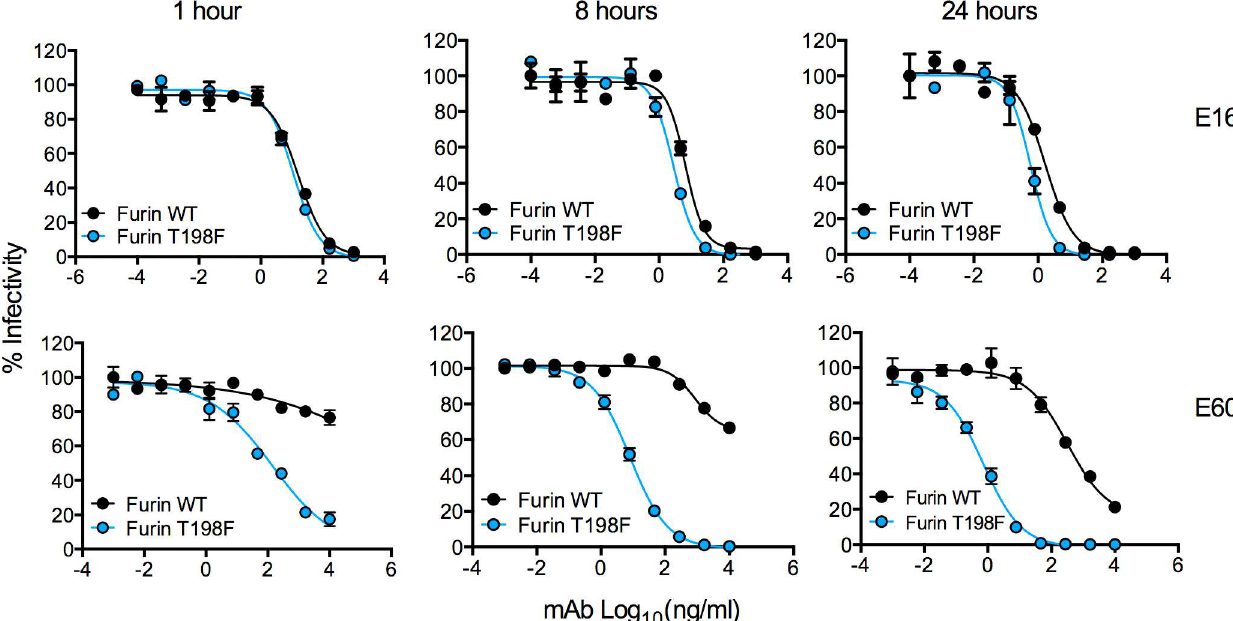
Fig 6. Kinetic aspects of neutralization of WNV E T198F RVPs. Furin WT and Furin T198F WNV RVPs were incubatedwith mAb E16 (top panel)or E60 (bottom panel)for 1 h at room temperature and were either immediately used to infect Raji-DC-SIGN-R cells or were further incubatedat 37˚C for additionallengthsof time as indicatedabovethe graphs prior to the addition of Raji-DC-SIGN-R cells. Percent infectivity versus mAb concentration is shown in each graph. Infectivity was normalizedto levels observedin the absenceof antibody.Error bars indicate the range of infectivity from duplicateinfections.Neutralization curves shown are representativeof five independentexperimentsperformed in